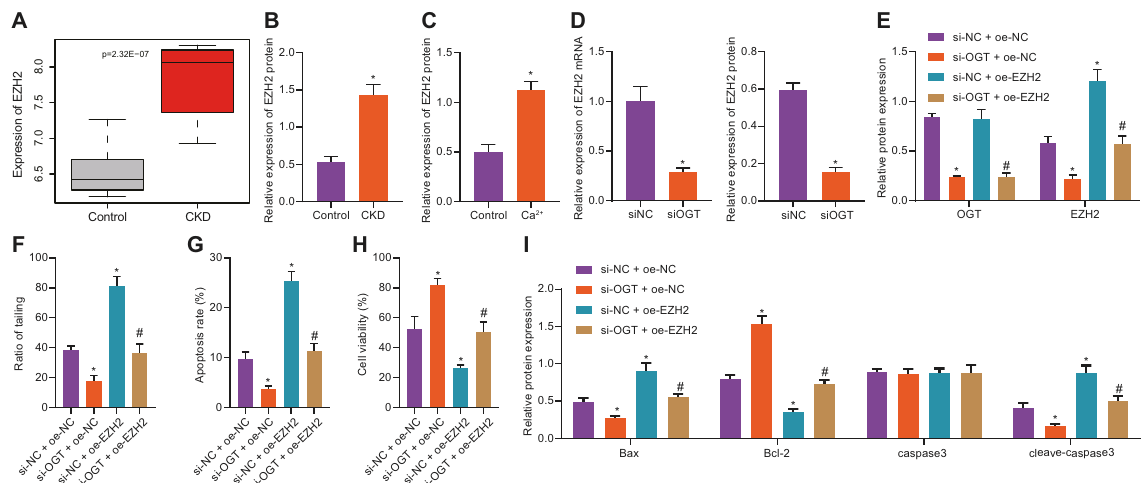
Fig. 3 Silencing OGT attenuates hypercalcemia-induced neurotoxicity by inhibiting EZH2 expression. A The expression of EZH2 in CKD mice of the GSE148084 dataset. B The expression of EZH2 in brain tissues of CKD mice was detected by Western blot analysis (n = 8). * p < 0.05. vs . the control group (mice on a standard diet). C Western blot analysis was used to detect the expression of EZH2 in neurons induced by hypercalcemia. * p < 0.05. vs . the control group (neurons cultured in basic medium). D RT-qPCR, and Western blot analysis were used to detect the effect of OGT silencing on EZH2 expression. * p < 0.05. vs . neuron treated with si-NC. E Western blot analysis was used to detect the expression changes of OGT and EZH2 after simultaneous silencing of OGT and overexpression of EZH2. F Comet assay was used to observe the DNA damage of neurons in each group. G Flow cytometry was used to detect neuronal apoptosis. H MTS method was used to detect the vitality of neurons in each group. I The expression of apoptosis-related proteins was detected by Western blot. ( E – I ), * p < 0.05. vs. the si-NC + oe-NC group (neuron treated with si-NC + oe-NC). # p < 0.05. vs. the si-OGT + oe-NC group (neuron treated with si-OGT + oe-NC). The experiment was repeated 3 times